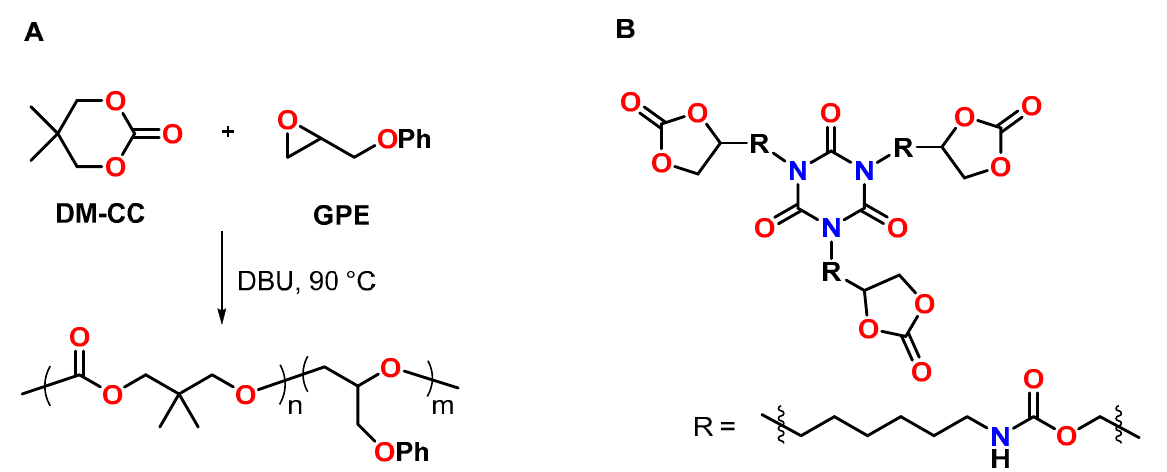
Figure 21. ( A ): Copolymerization of the cyclic carbonate DM-CC with phenyl glycidylether GPE. ( B ): Chemical structure of trifunctional cyclic carbonates.